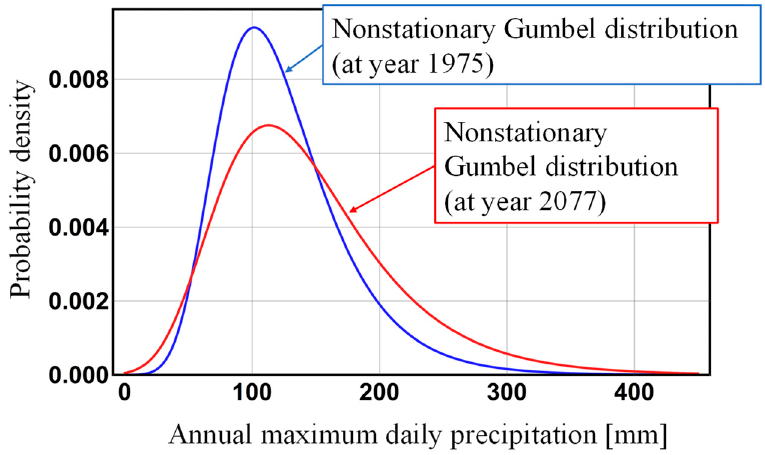
Figure 8. Future changes in the non-stationary Gumbel distribution fitted to observed data of annual maximum daily precipitation over 142 years (from 1876 to 2017) at the ground observation station Tokyo. The blue solid line is the non-stationary Gumbel distribution in 1975 and the red solid line is the non-stationary Gumbel distribution in 2077.